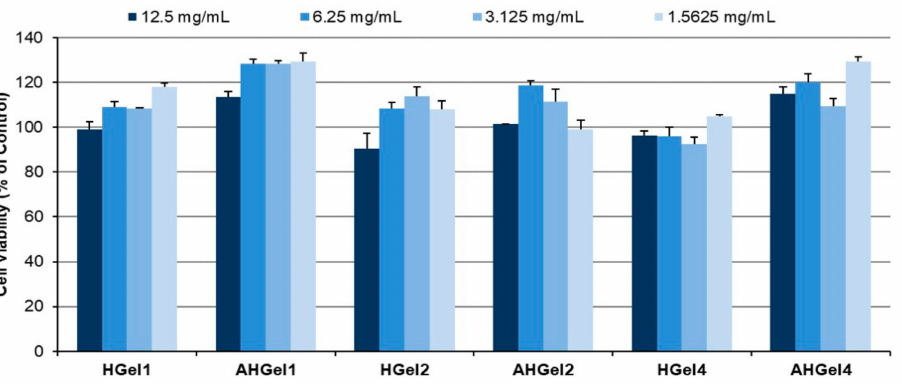
Figure 7. Viability of normal fibroblasts exposed to hydrogel extracts (12.5/6.25/3.125/1.5625 mg/mL) for 24 h. Experiments were performed in triplicate, and the viability of treated cells was expressed as a percentage of the viability of Control cells. Data plotted were expressed as means ± standard error of the